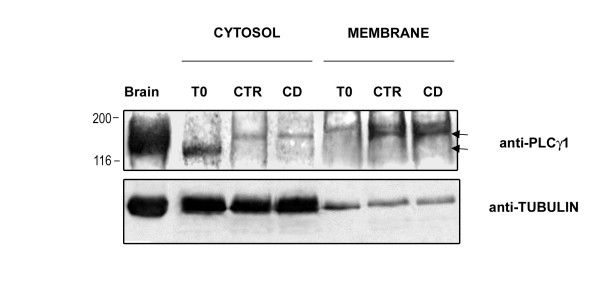
Capacitation-dependent PLCγ1 relocalization. Western Blot analysis of PLCγ1 localization in cytosolic and membrane fractions of freshly ejaculated male gametes (T0) or in spermatozoa incubated under control condition (CTR) or in the presence of CD (CD). The data showing the capacitation-dependent translocation of PLC-γ1 (arrows) from cytosol to membrane. Brain proteins were used as positive control. The filter was normalized on Tubulin expression. The data shown were representative of four independent experiments.